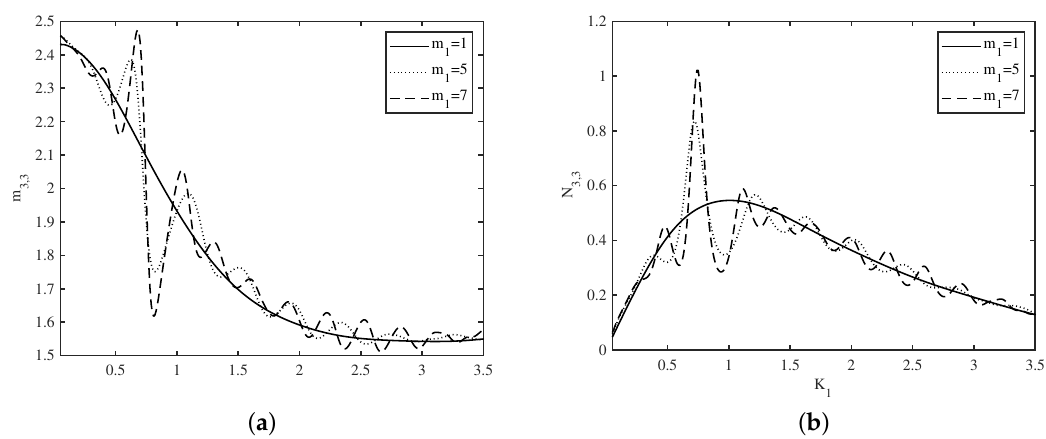
Figure 10. Variation of ( a ) m 3,3 and ( b ) N 3,3 vs K 1 for different m 1 .